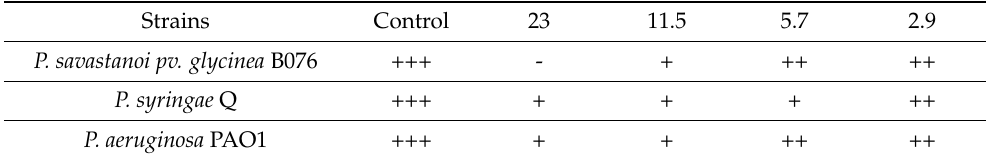
Table 5. E ff ect of TEO (mg/mL) on the swarming of P. syringae strains and P. aeruginosa PAO1. Strains